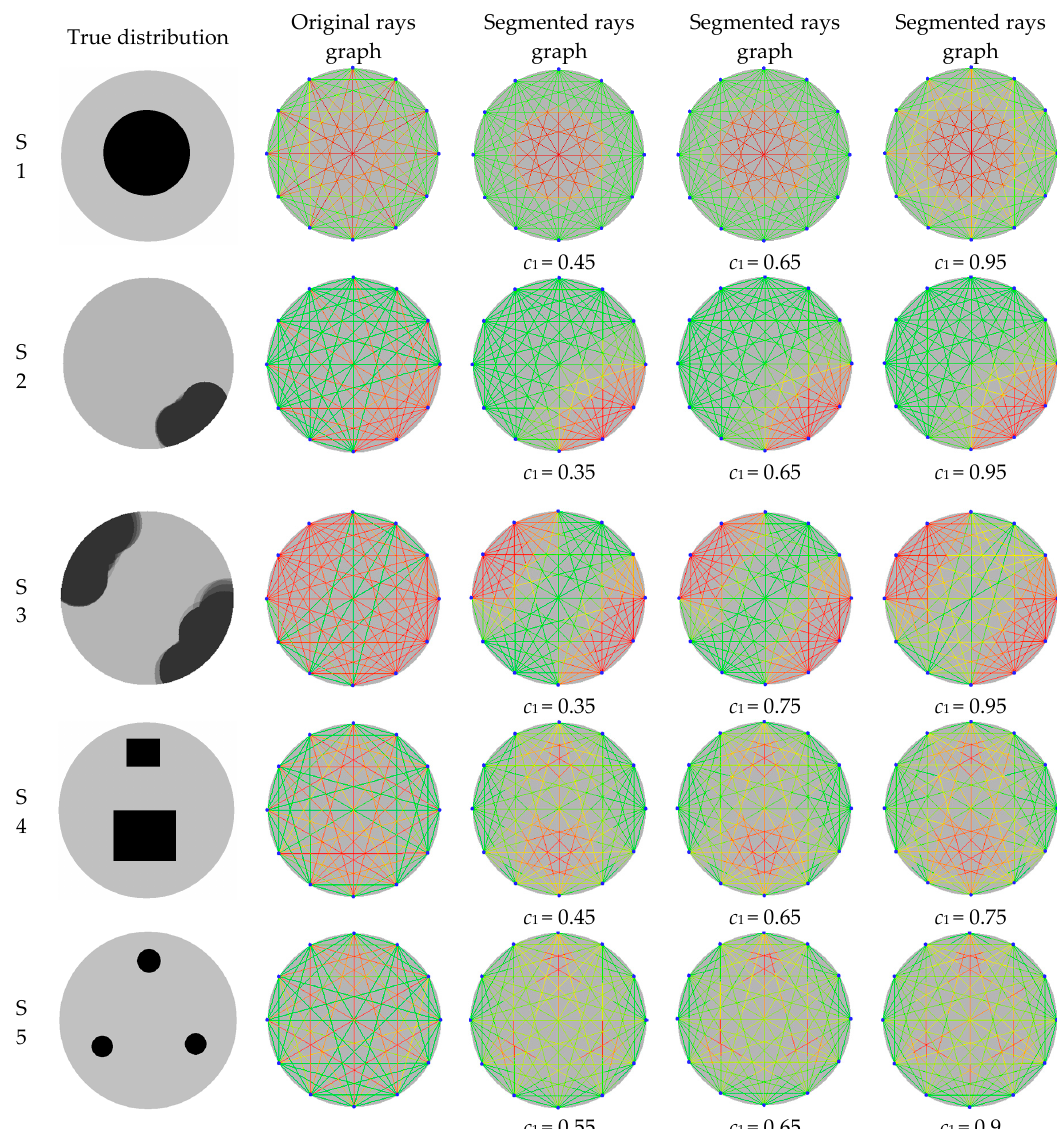
Figure 6. Original rays graph and segmented rays graph using the RSEN method from simulation data with different control coefficients.